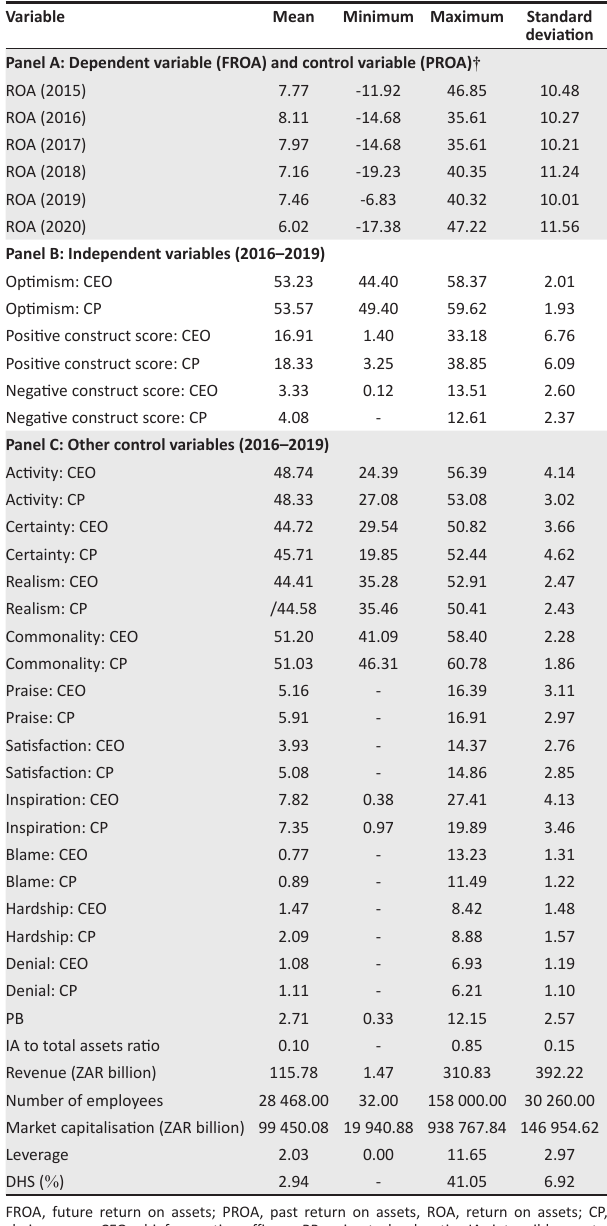
TABLE 1: Descriptive statistical